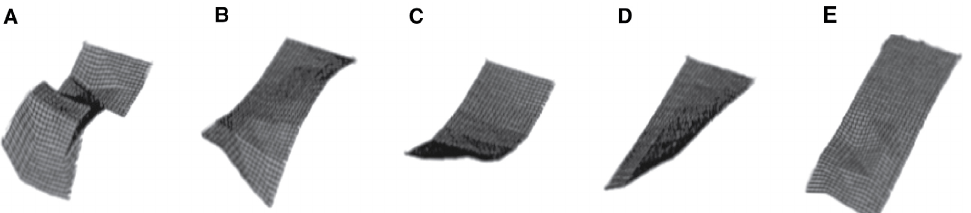
Figure 3: ESPI fringe patterns at different resonance modes (no hole specimen). (A) First mode (B) second mode (C) third mode (D) fourth mode (E) fifth mode.